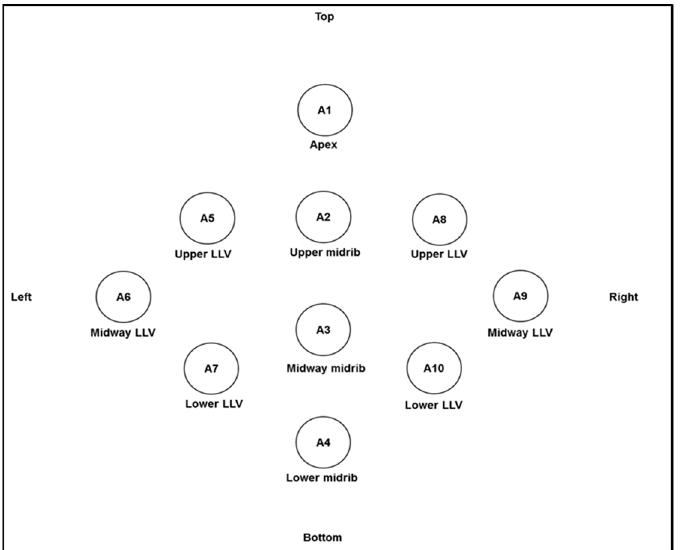
Figure 1. Diagrammatic representation of leaf disc positions taken from older L. sativa leaves (This is not to scale. Key: LLV, lamina and lateral veins.